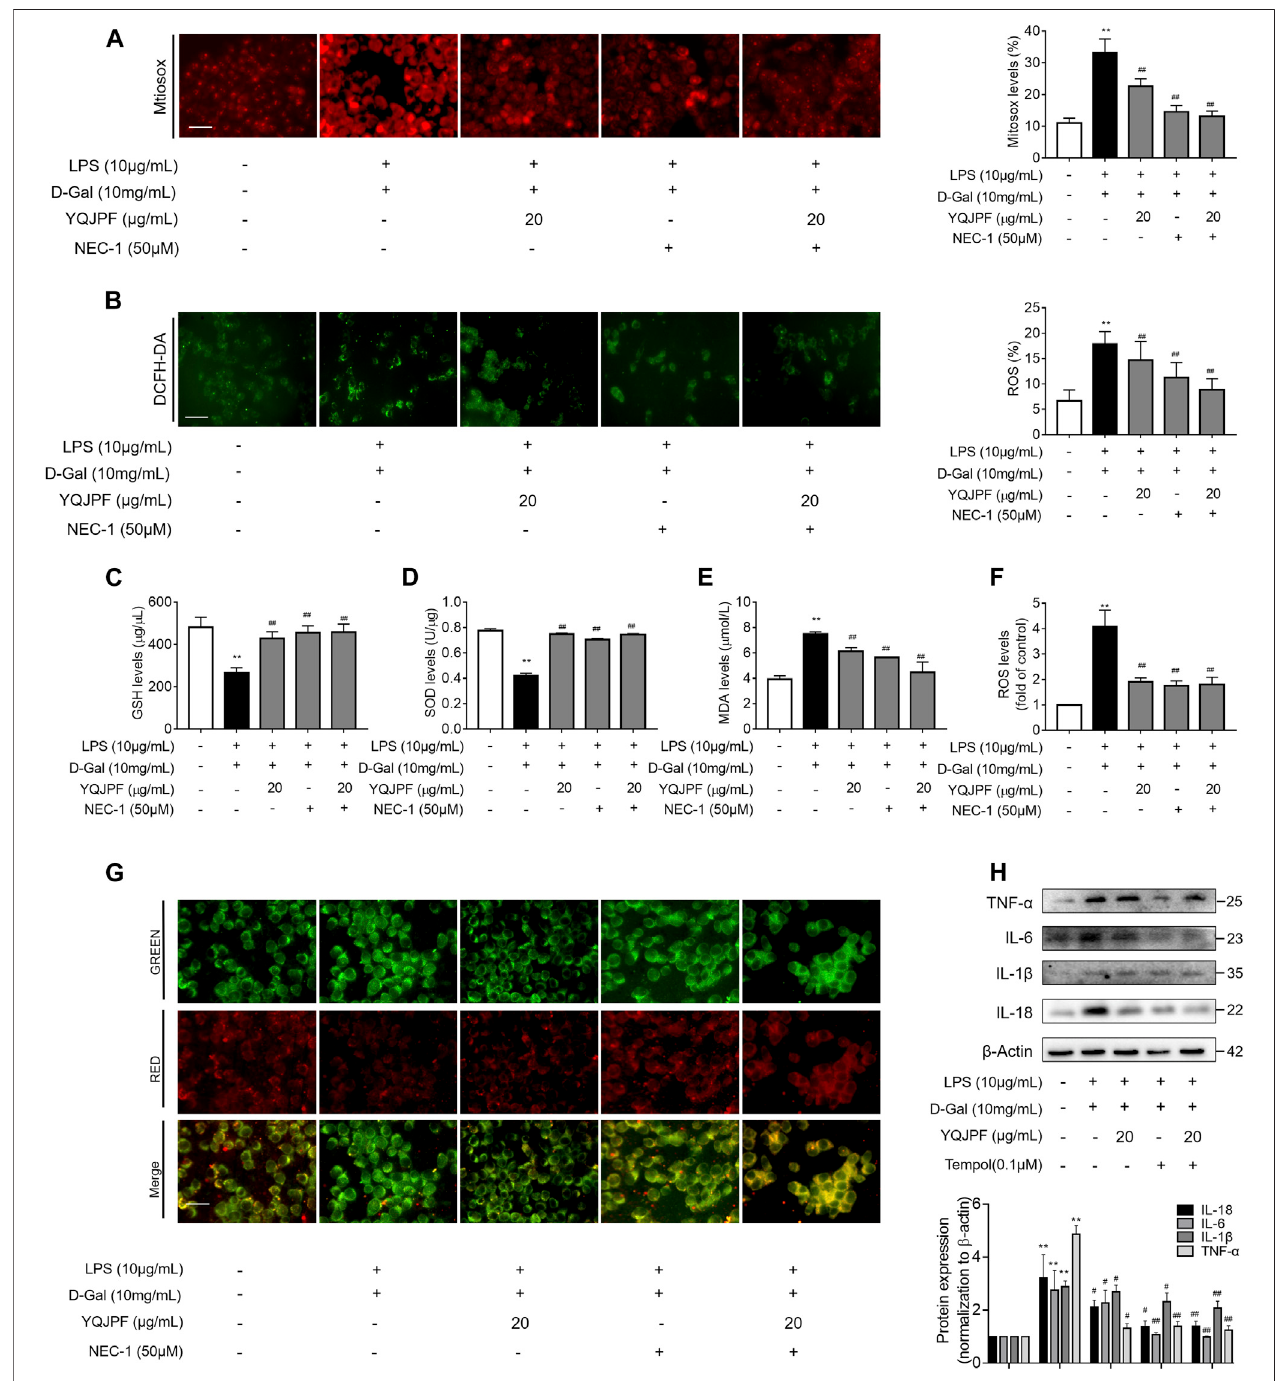
FIGURE 9 | YQJPF inhibited hepatocyte necroptosis through the inhibition of mitochondrial ROS generation and depolarization in vitro . Human LO2 cells were treatedwithLPS+D-Galfor4 handfurtherpre-treatedwith50 μ MNec-1for1 h,followedbyYQJPForatractylonetreatmentfor24 h. (A) Mitochondrialsuperoxidewas detectedandquanti fi edthroughimmuno fl uorescencebyusingMitoSoxRedstaining.Scalebar,50 μ m. (B) ROSproductionwasassessedandquanti fi edbyDCFH-DA staining, Scale bar, 50 μ m. (C – E) MDA, SOD, and GSH levels were measured by corresponding test kits. (F) ROS levels were assessed using ROS test kit. (G) Mitochondrial membrane potential was detected by JC-1 staining. Scale bar, 50 μ m. (H) Western blot and quantitative analysis of the expression of IL-1 β , IL-6, TNF- α , and IL-18. Data are expressed as mean ± SD ( n (cid:2) 3). *vs. control group, # vs. LPS + D-Gal group; * p < 0.05, ** p < 0.01; # p < 0.05, ## p < 0.01.